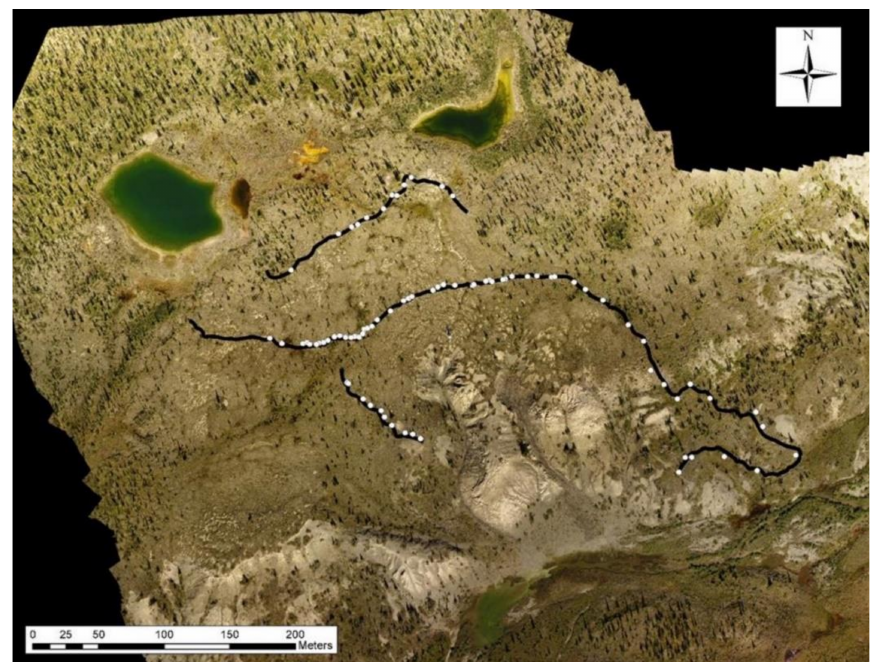
Figure 2. A photomosaic of the study site with the three fences indicated by black lines, with locations of where 89 archaeological individual samples were collected marked by white dots along the fences. The longest main fence structure continues over the steep embankment and ends in a hooked corral-like structure in the southeast section of the study site.